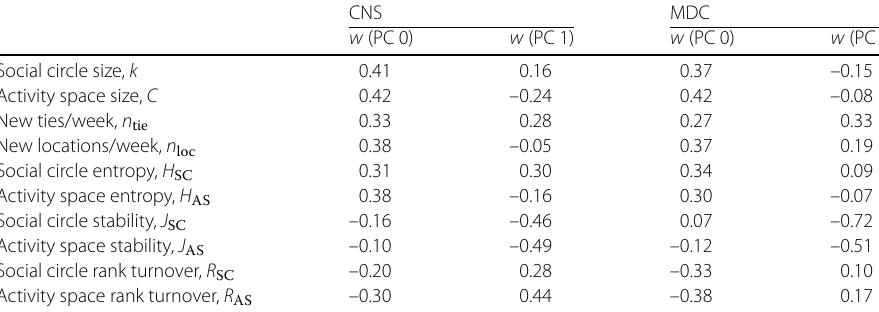
Table 7 Contribution of the original variables to the first principal component. The scalar projection w of the first (PC 0) and second (PC 1) principal components, along the axis defined by each of the original variables. Each principal component has unit norm, hence the sum of w 2 is 1. Results are shown for the CNS and MDC datasets CNS